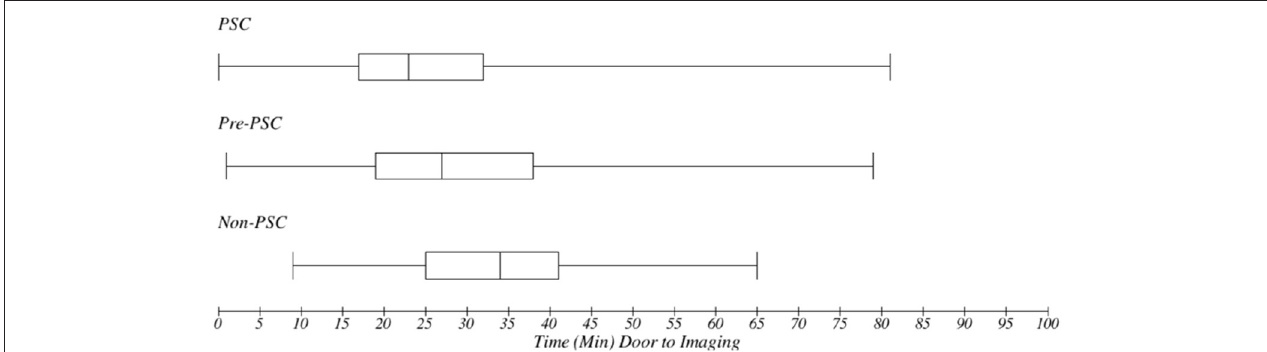
FIGURE 1 | Metrics of acute stroke care quality: time (minutes) from door to imaging: median time with interquartile range in minutes from emergency department (ED) arrival (door) to first brain scan (imaging) was 23 (17–32) at PSCs, 27 (19–38) at pre-PSCs, and 34 (25–41) at non-PSCs ( p < 0.001). PSCs had a faster time from ED arrival to first brain